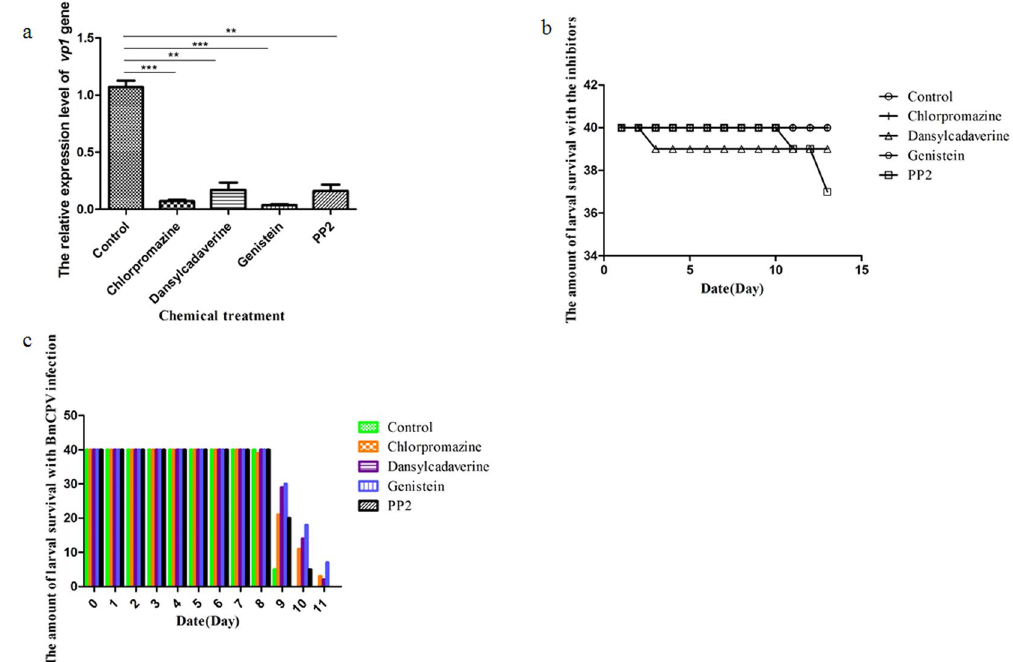
Figure 4. The inhibition effect on BmCPV infection of silkworms with endocytic inhibitors. ( a ) Silkworms were fed mulberry leaves coated with water (control), 1 mM chlorpromazine, 1 mM dansylcadaverine, 0.08 μ M PP2, or 25 μ g/mL genistein, and then they were infected with BmCPV. The dissected midguts from 15 silkworm larvae at 120 h post-infection were used to isolate total RNA. The relative expression level of the BmCPV vp1 gene in the silkworm midgut at 120 h post-infection was determined by RT-qPCR. Error bars indicate standard deviations. * P < 0.5; ** P < 0.01. ( b ) Silkworms were fed mulberry leaves coated with water (control), 1 mM chlorpromazine, 1 mMdansylcadaverine, 0.08 μ M PP2, or 25 μ g/mL genistein, and the survival of the silkworms with endocytic inhibitors was calculated to test the endocytic inhibitors’ toxicity in 13 days. ( c ) Silkworms were fed mulberry leaves coated with water (control), 1 mM chlorpromazine, 1 mMdansylcadaverine, 0.08 μ M PP2, or 25 μ g/mL genistein, and then they were infected with BmCPV. The amount of larval survival with BmCPV infection was calculated after 11 days.